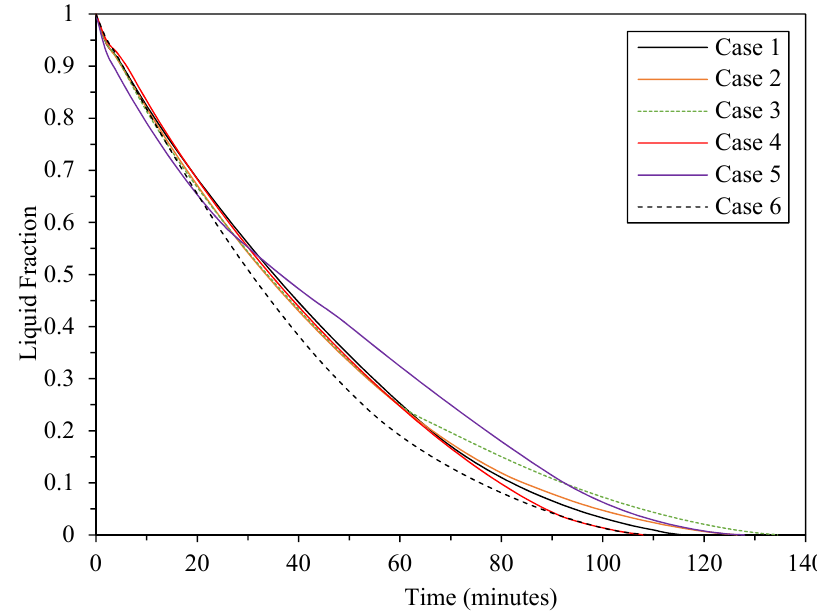
Figure 7. Liquid-fraction evolution for studied cases.